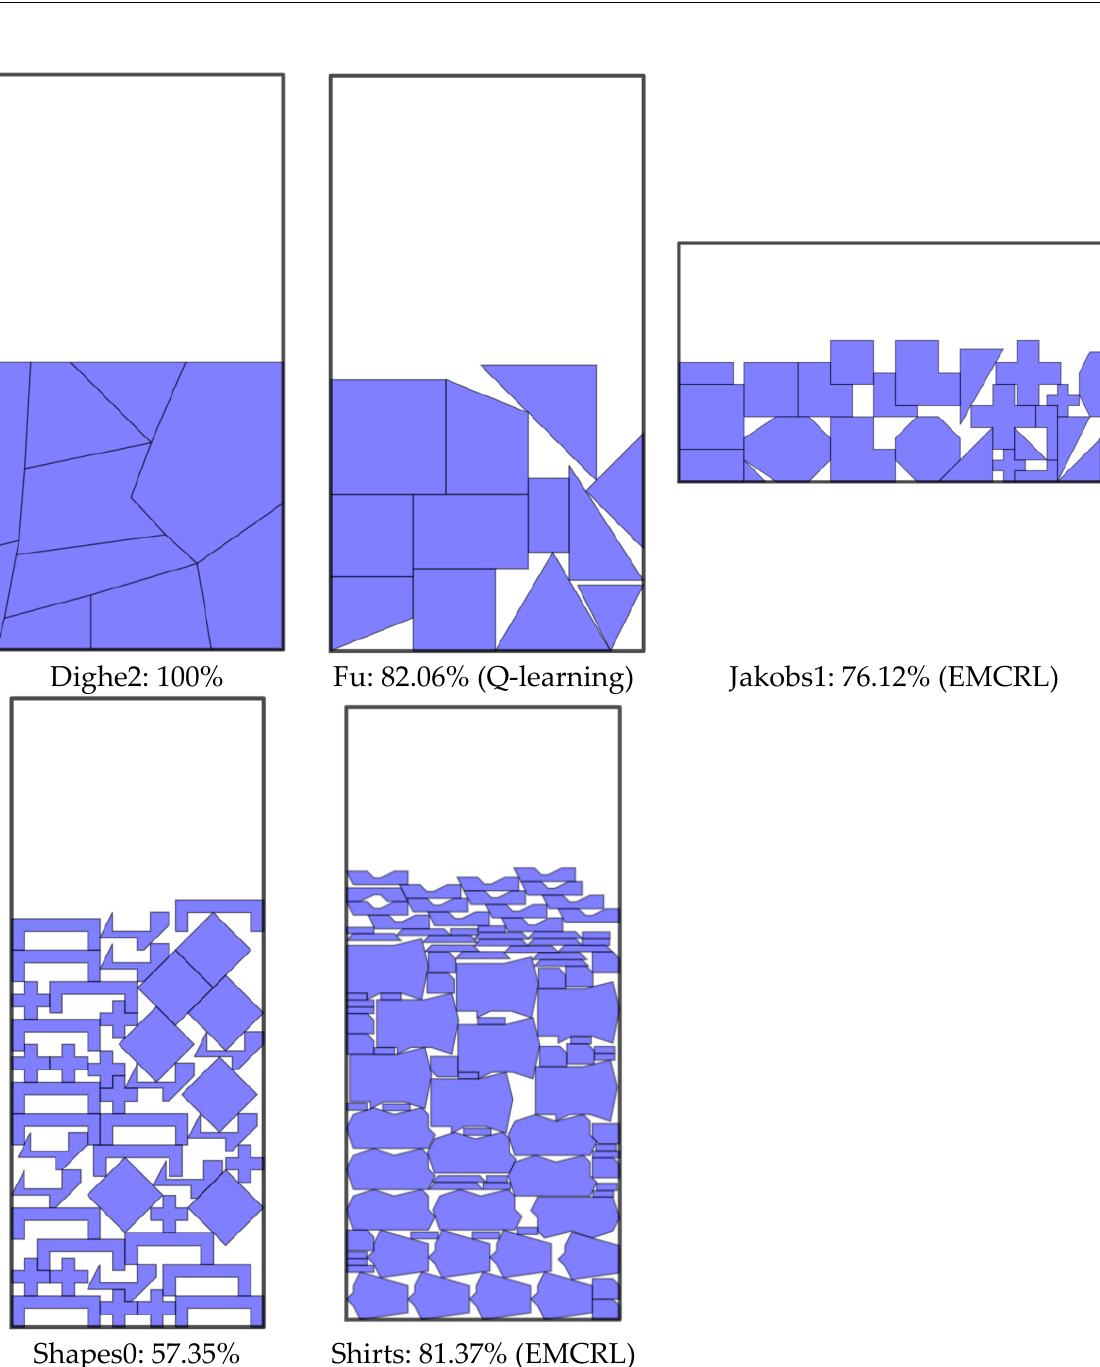
Figure 9. The layout of the best results for five instances of the packing algorithm based on RL .